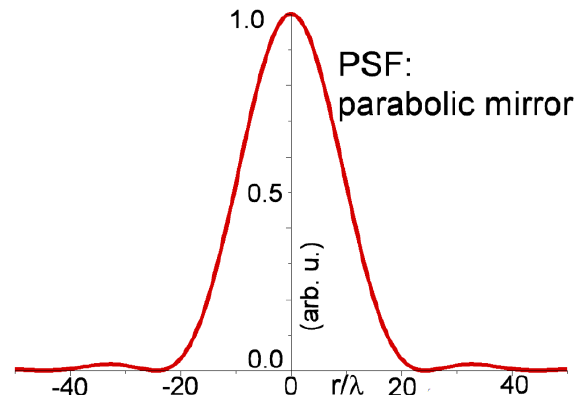
Figure 4. PSF focus radial intensity profile of parabolic mirrors expected from construction parameters. Normalized radial units are used.